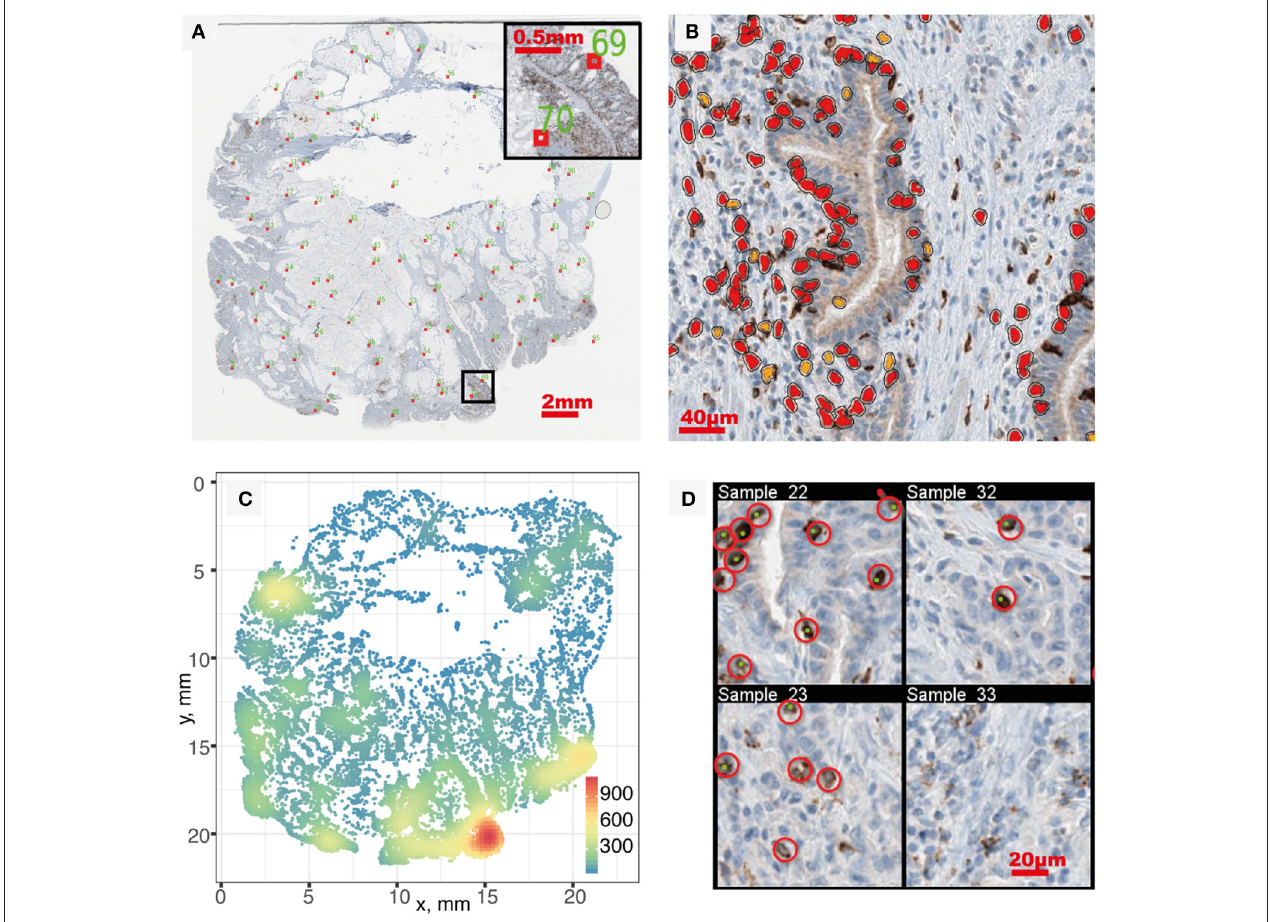
FIGURE 2 | Image segmentation and segmentation quality evaluation. (A) IHC whole slide, red boxes indicate sampled location for quality evaluation. (B) Segmentation result of a sub-region. Orange and red correspond to positive staining with thresholds of OD > 0.5 and OD > 0.7, respectively. (C) Full point pattern. Color indicates cell density (mm − 2 ). (D) In each sampled region, manual identification of CD8 result (green dots) to evaluate performance. Four sampled windows are